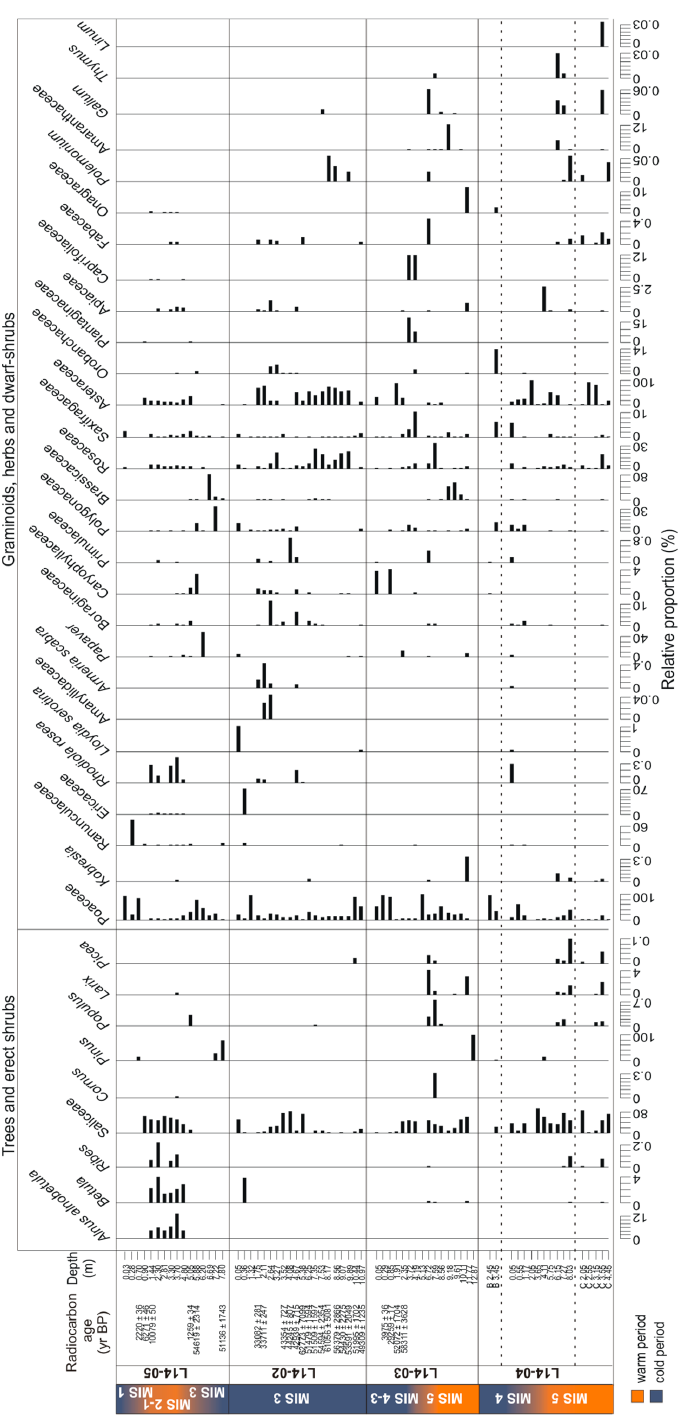
Figure 3. Stratigraphic diagram representing relative proportions of terrestrial sedaDNA sequences in each sample of the four permafrost cores (L14–05, L14–02, L14–03, L14–04) and the hand ‐ pieces (collected soil nuggets from outcrops: L14–04B, L14–04C). The radiocarbon ages (yr BP) and the corresponding marine isotope stages (MIS) are displayed on the left side, with warmer periods in orange and colder periods in blue. The scales of the relative proportions are for each taxon.